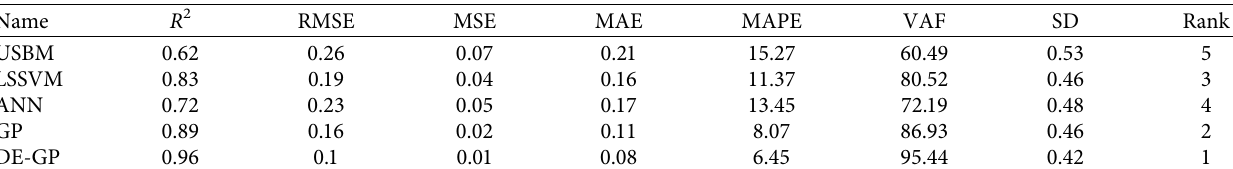
Figure 12: Relationship between measured and predicted PPV by various prediction methods. Table 7: Evaluation effect of various prediction methods.